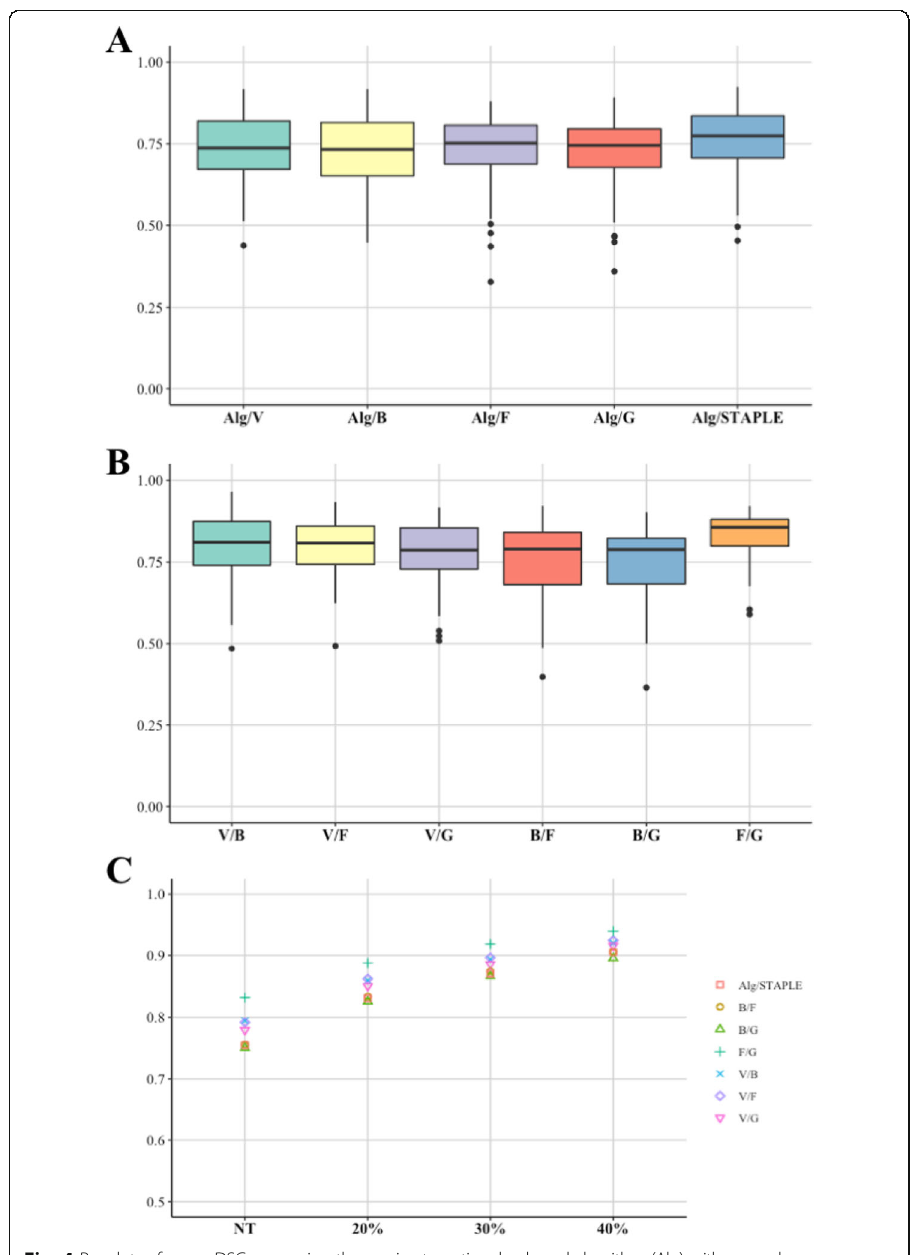
Fig. 4 Boxplots of mean DSC comparing the semi-automatic edge-based algorithm (Alg) with manual segmentations and with STAPLE ( a ), comparing manual segmentations by different operators ( b ) and comparing different manual segmentations and Alg with STAPLE for different SUV max thresholds (NT, no threshold applied) ( c